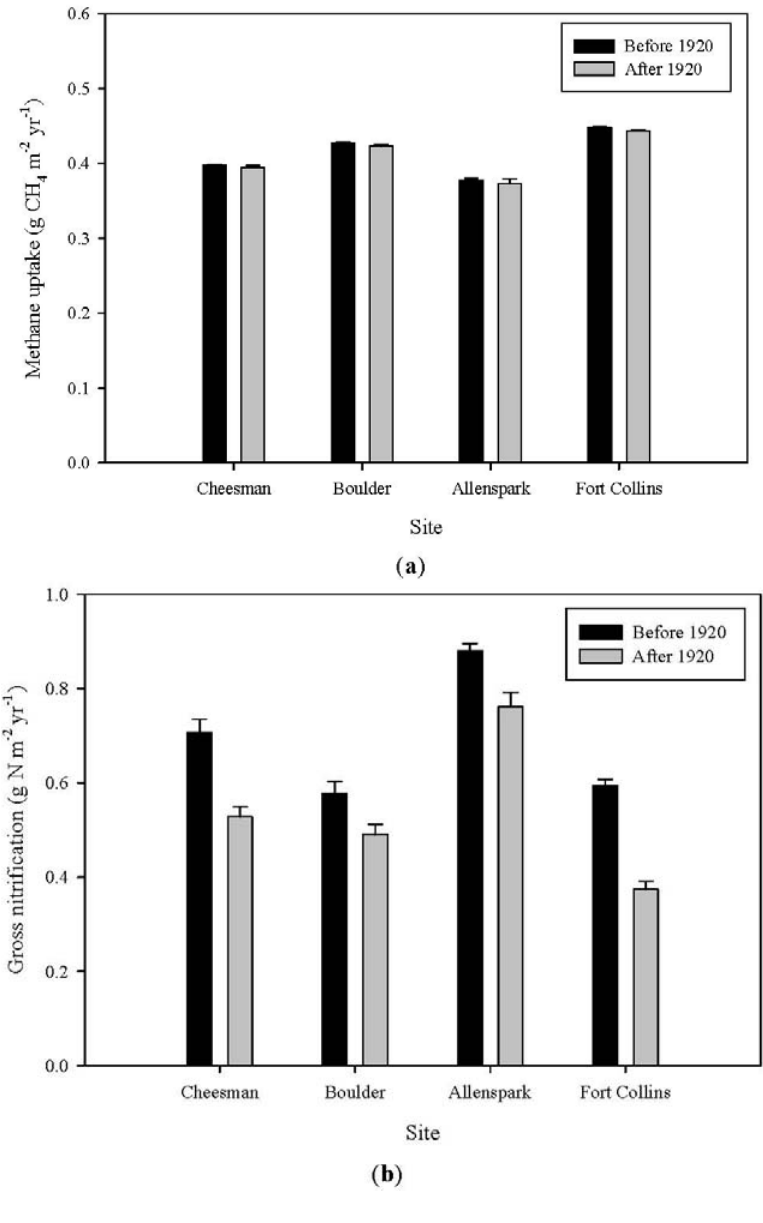
Figure 3. Means and standard error of ( a ) methane uptake rates (g·CH nitrification (g·N·m − 2 ·yr − 1 ); ( c ) nitrous oxide fluxes (g·N fluxes (g·NO·m − 2 ·yr − 1 ), for each of the four simulated locations. Gray bars depict the respective values for the fire suppression period (after 1920) whereas the black bars represent the pre-1920 (no fire suppression)